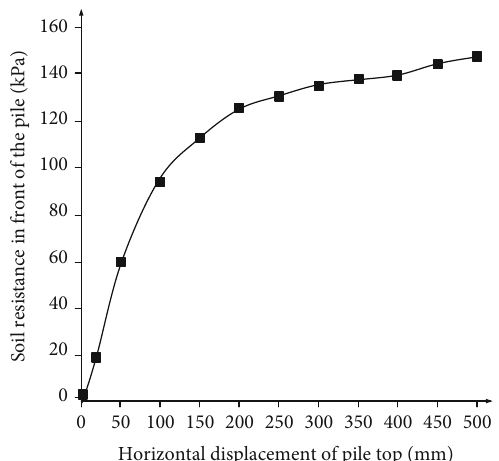
Figure 11: Resistance of soil in front of pile at 0 ~ 1 m depth.